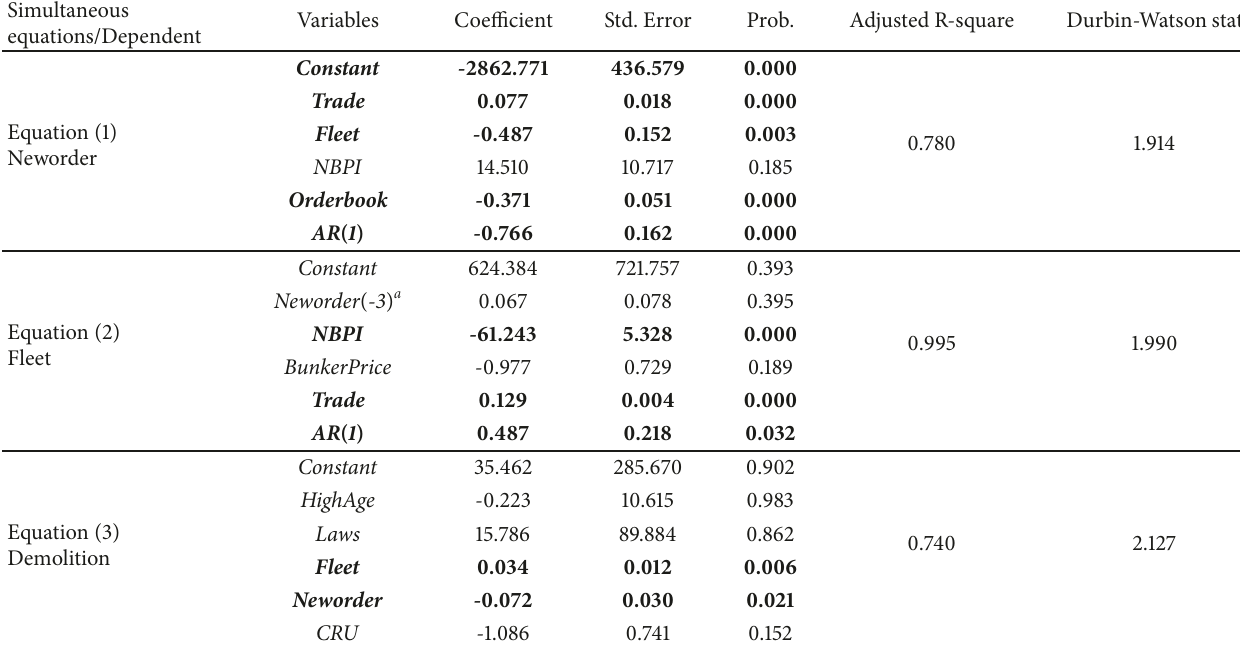
Table 3: Estimated results of the SEM for container